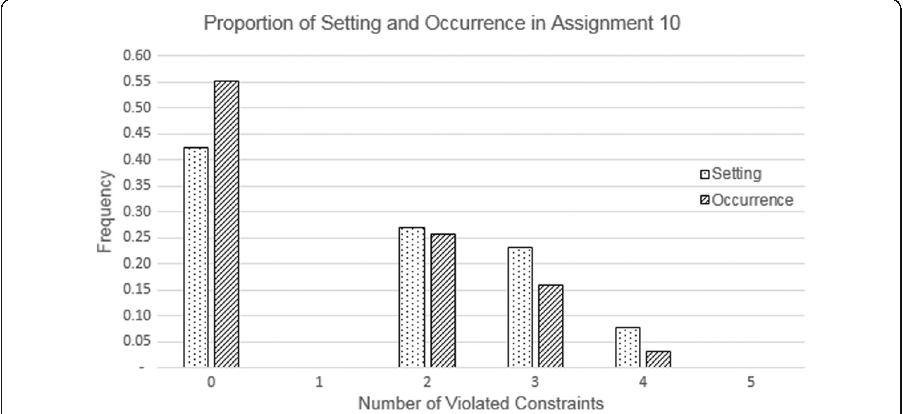
Fig. 9 Portion of the number of states in assignment 10 to the occurrence